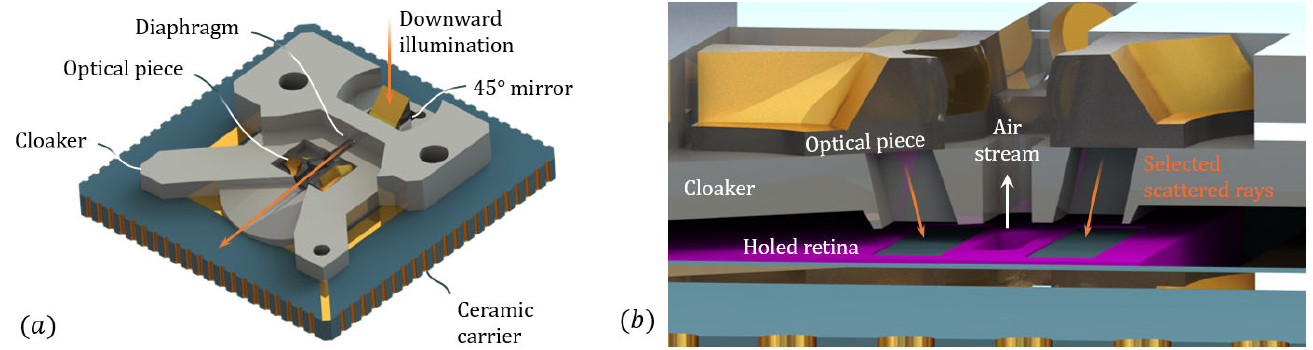
Figure 9. ( a ) 3D view of the optical piece with the cloaker and the holed retina mounted on ceramic. ( b ) Cross-sectional view of the optical setup, showing the optimized apertures.